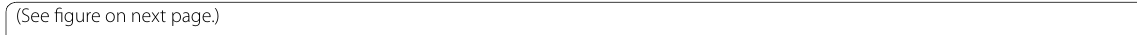
figure on next Fig. 4 TECR derived from pseudorange and carrier phase observations of GPS, GLONASS, Galileo, and BDS signals as tracked by receiver 1 (left column) and receiver 2 (right column) during test period 1 (GPS time: 3:00:00–9:00:00) ( a and b ) and test period 2 (GPS time: 11:00:00–14:00:00) ( c and d ). a TECR derived from GNSS pseudorange observations of receiver 1 (without HST window glass, left column) and receiver 2 (with HST window glass, right column) during period 1; b TECR derived from GNSS carrier phase observations of receiver 1 (without HST window glass, left column) and receiver 2 (with HST window glass, right column) during period 1; c TECR derived from GNSS pseudorange observations of receiver 1 (without HST window glass, left column) and receiver 2 (without HST window glass, right column) during period 2; d TECR derived from GNSS carrier phase observations of receiver 1 (without HST window glass, left column) and receiver 2 (without HST window glass, right column) during